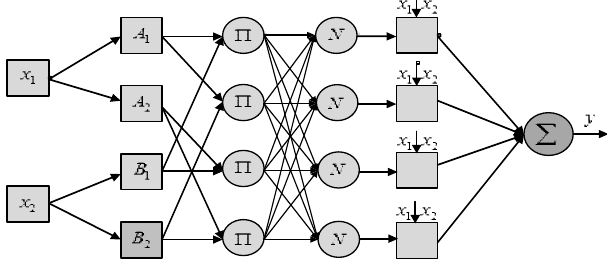
Figure 2. Typical two-input ANFIS structure.